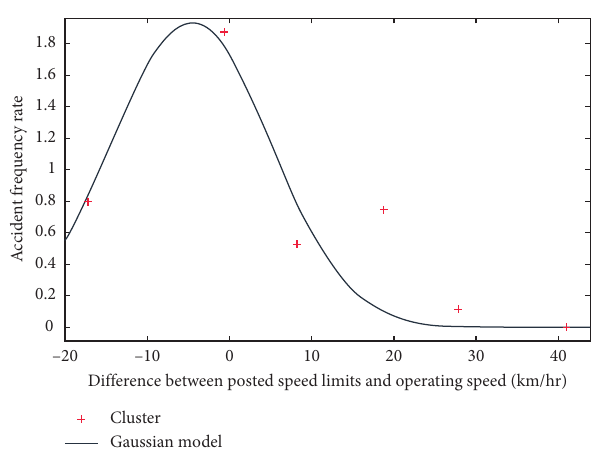
Figure 6: The relationship between the difference of posted speed limits and the operating speed and the accident frequency rate based on the proposed